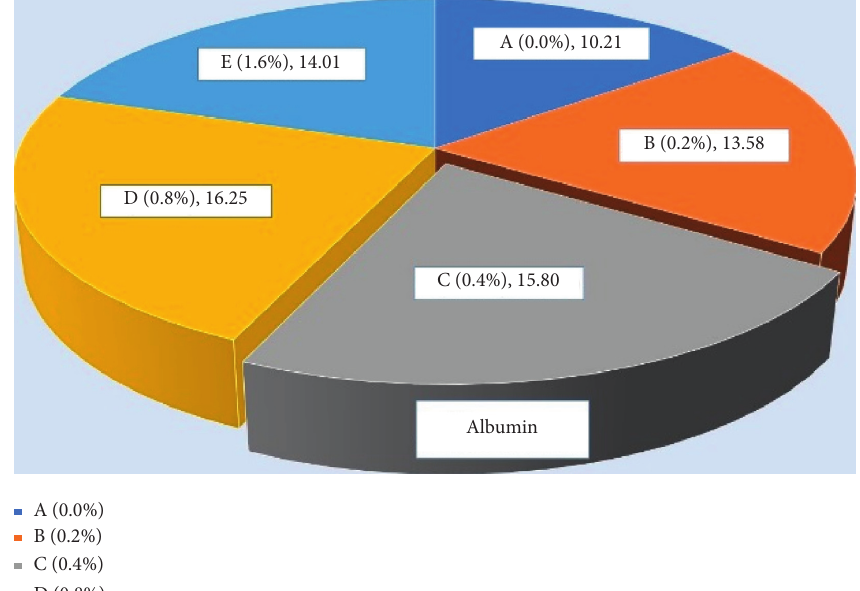
Figure 11: Cyprinus carpio fed varied doses of Aloe vera and albumin contents from liver tissues were studied after 90 days of feeding